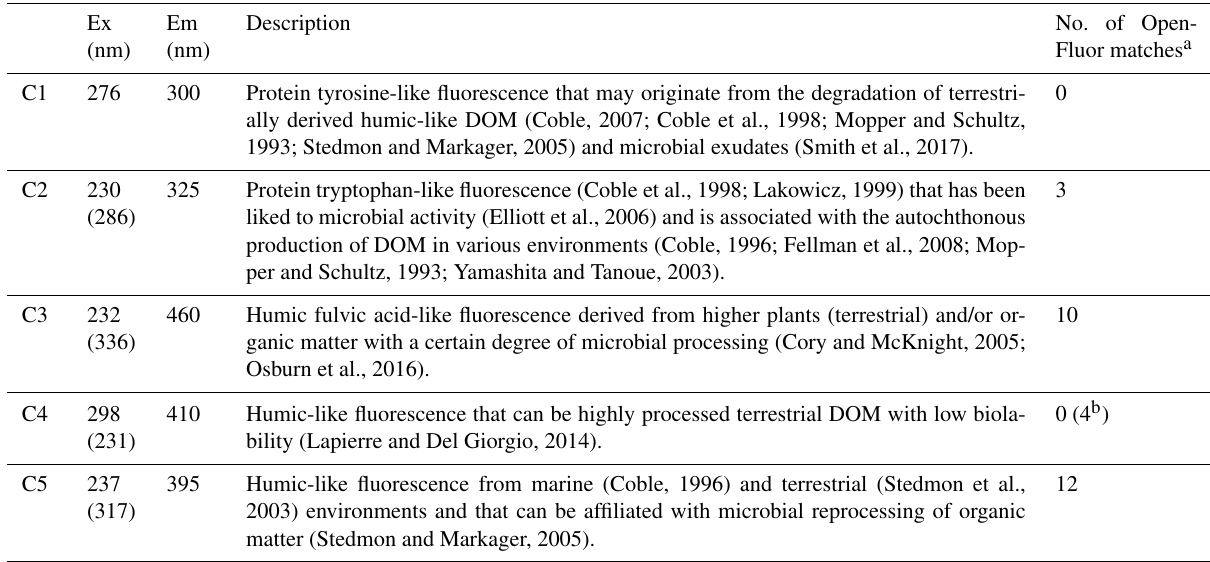
Table 2. Excitation and emission maxima for the five-component PARAFAC model, including the identification of each component.